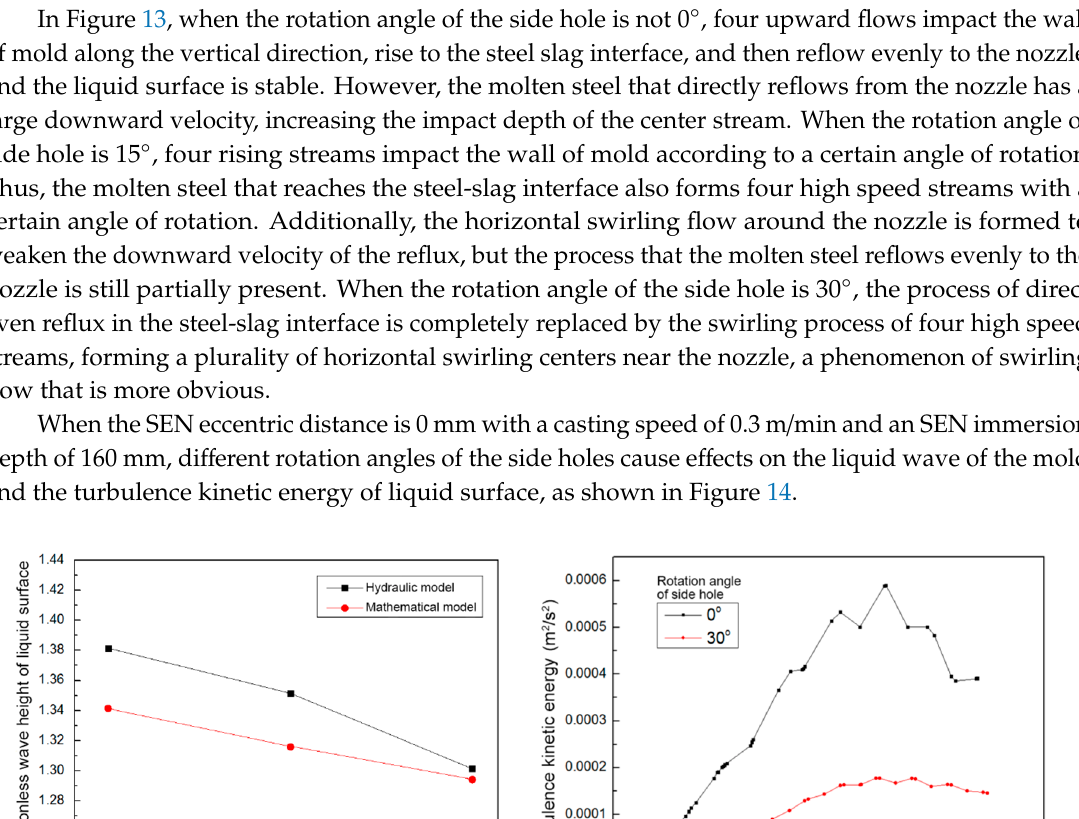
Figure 13. Velocity vector of the steel-slag interface in different rotation angles of the side hole. ( a ) The rotation angles on the side hole of the SEN is 0°; ( b ) The rotation angles on the side hole of the SEN is 15°; ( c ) The rotation angles on the side hole of the SEN is 30°.